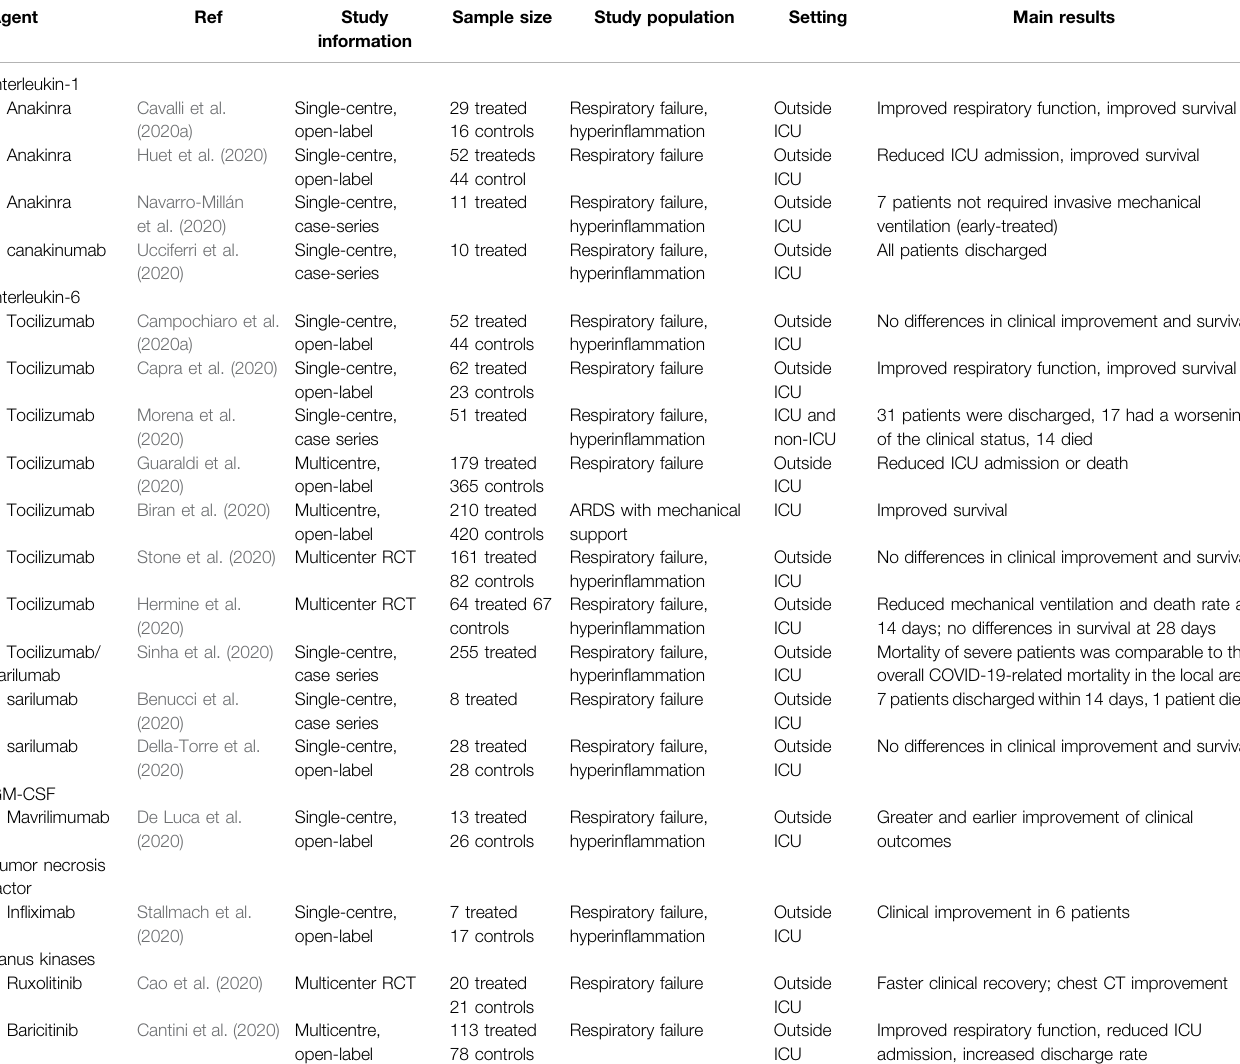
TABLE 1 | Main published observational studies and randomized trials of biologic and targeted synthetic drugs for the treatment of SARS-CoV-2 – induced hyperin fl ammation.